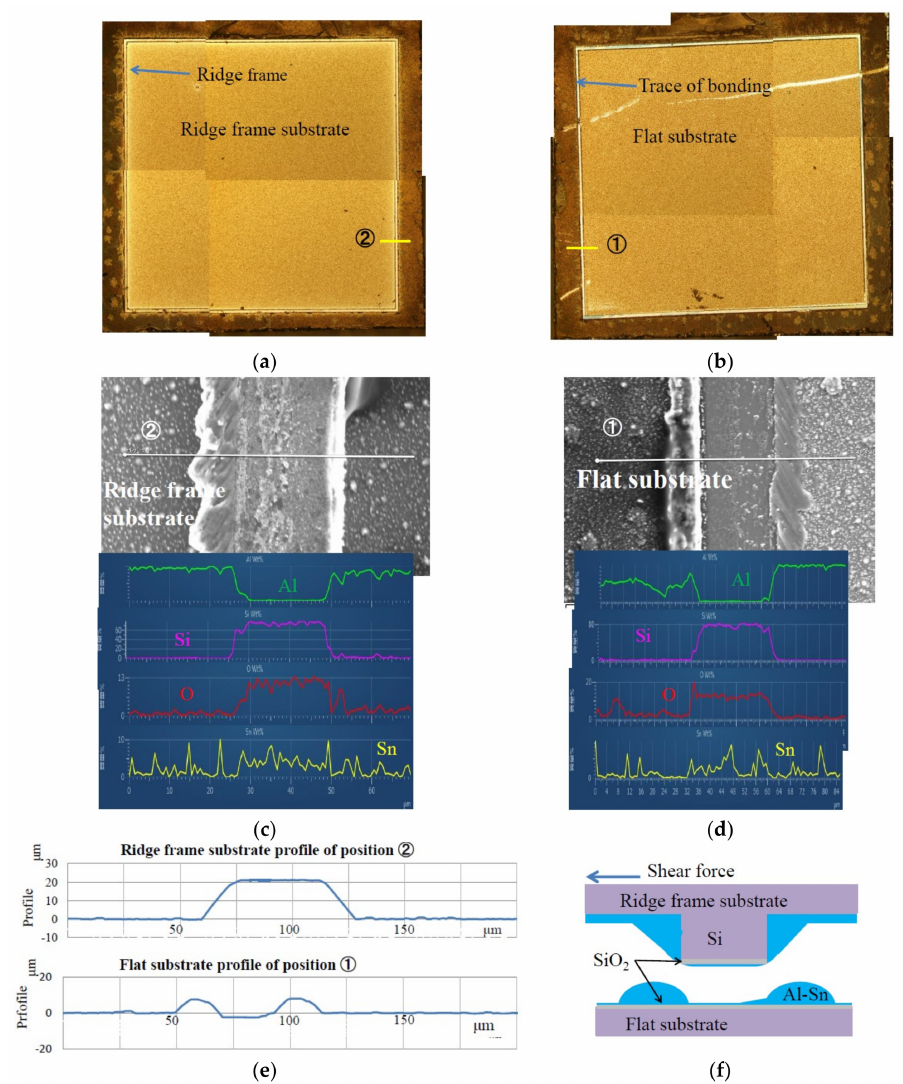
Figure 6. Results of EDX, SEM, and surface profile measurements of shear-fractured dies. ( a ) Surface photograph of ridge frame substrate; ( b ) Surface photograph of flat substrate; ( c ) SEM and EDX results of ridge frame substrate; ( d ) SEM and EDX results of flat substrate; ( e ) Surface profiles of separated substrates; ( f ) Schematic cross section of bonded area after fractured by shear